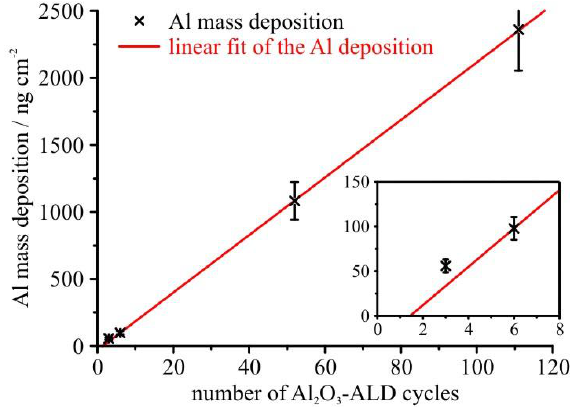
Figure 4. Al mass deposition on SiO reference-free GIXRF at a glancing angle of